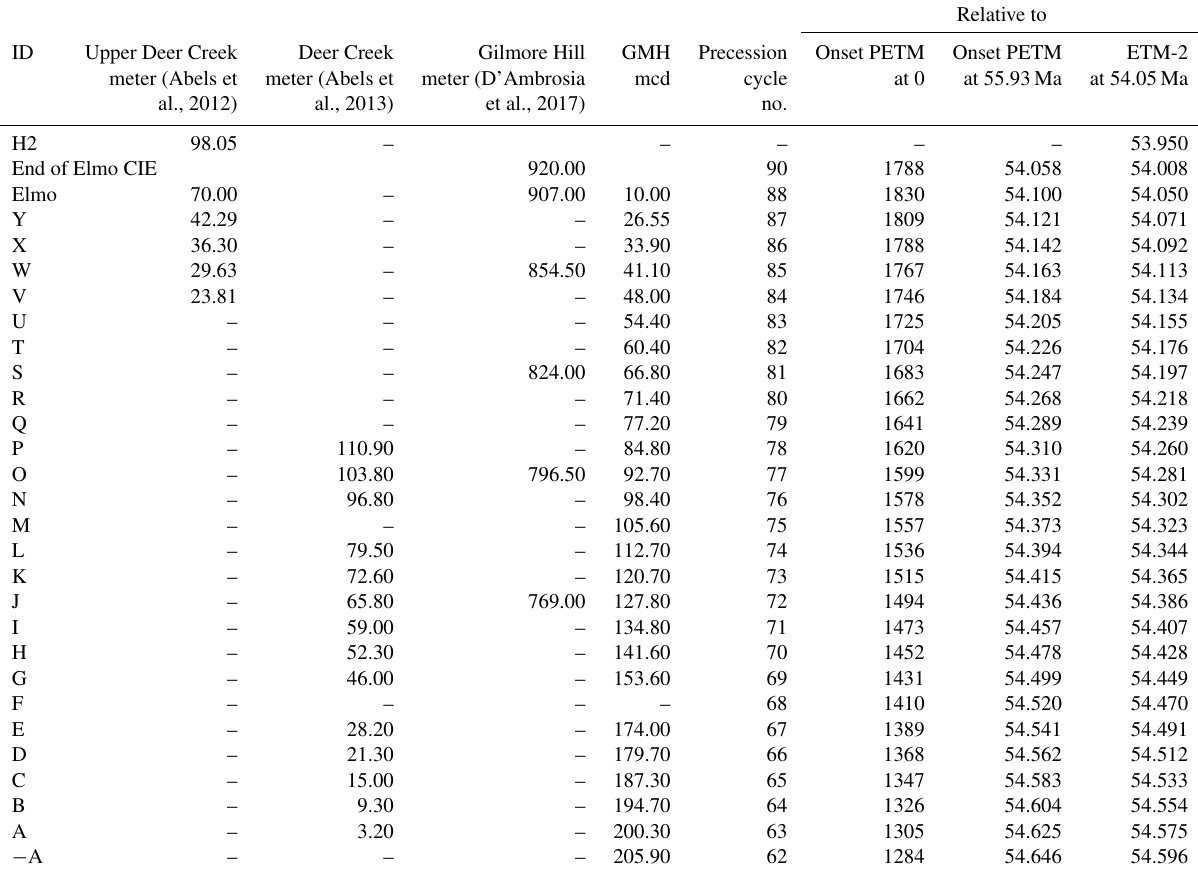
Table 2. Age model for Gilmore Hill (GMH) drill core and regional outcrops. From left to right: labeling ID for identified precession cycles (see text for details), the respective depth of the assigned precession cycles in the Upper Deer Creek, the Deer Creek, and the Gilmore Hill sections as well as the Gilmore Hill BBCP drill core. Precession cycle number as defined at ODP sites counting precession cycles (Westerhold et al., 2007) followed by the relative and absolute age to the onset of the PETM assuming 21kyr duration for each precession cycle counted, using 55.930Ma for the onset of the PETM (Westerhold et al., 2007) and using 54.050Ma for the absolute age of ETM-2 (Westerhold et al.,